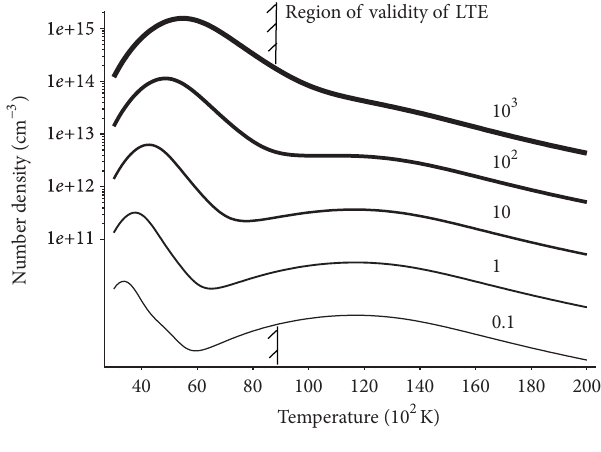
F 4: Density of sodium at Na(3p)-excited states, as function of temperature, in equilibrium plasma induced on MgCl aqueous solution, for different sodium concentration (shown in g L −1 ⋅